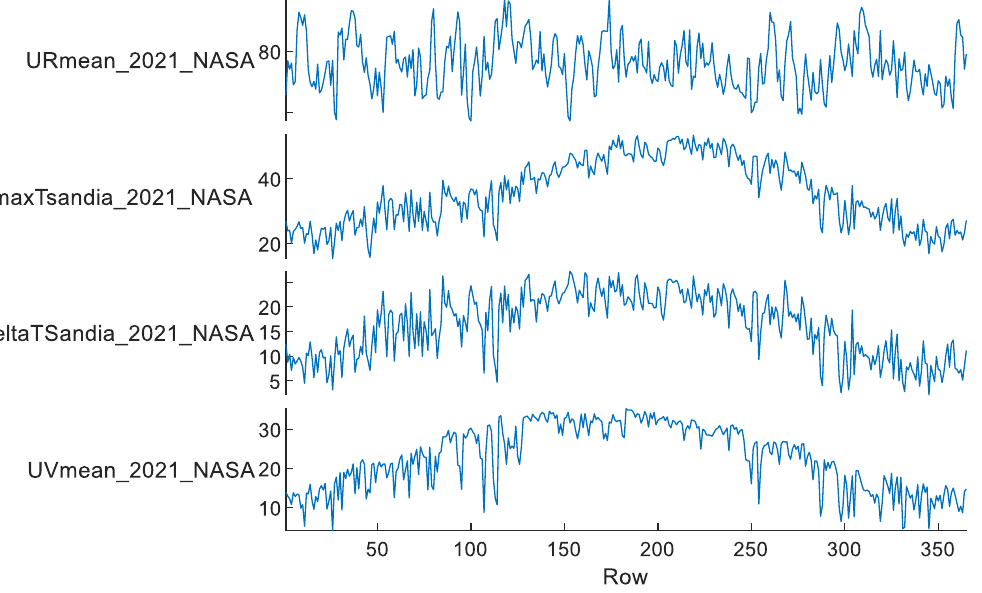
Figure 6. Offshore weather input data, 2021. From top to bottom: RH daily (%), T max ( ◦ C), ∆ T daily ( ◦ C), UV daily ( W/m 2 ).